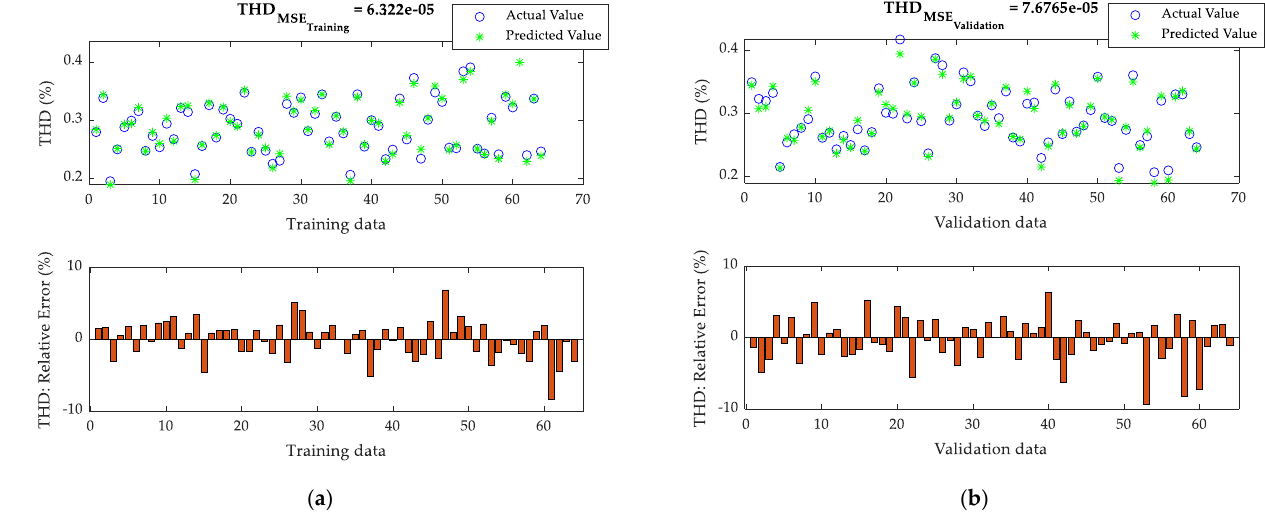
Figure 14. Results of the tuned FIS in the first step for THD: ( a ) training data; ( b ) validation data.